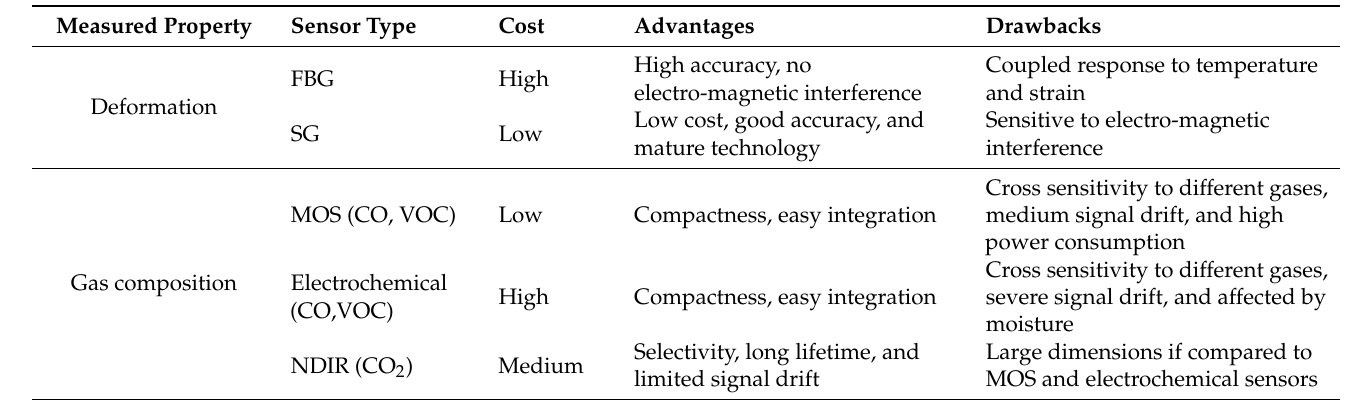
Table 1. Comparison of different sensor technologies for mechanical and chemical monitoring of Li-ion battery